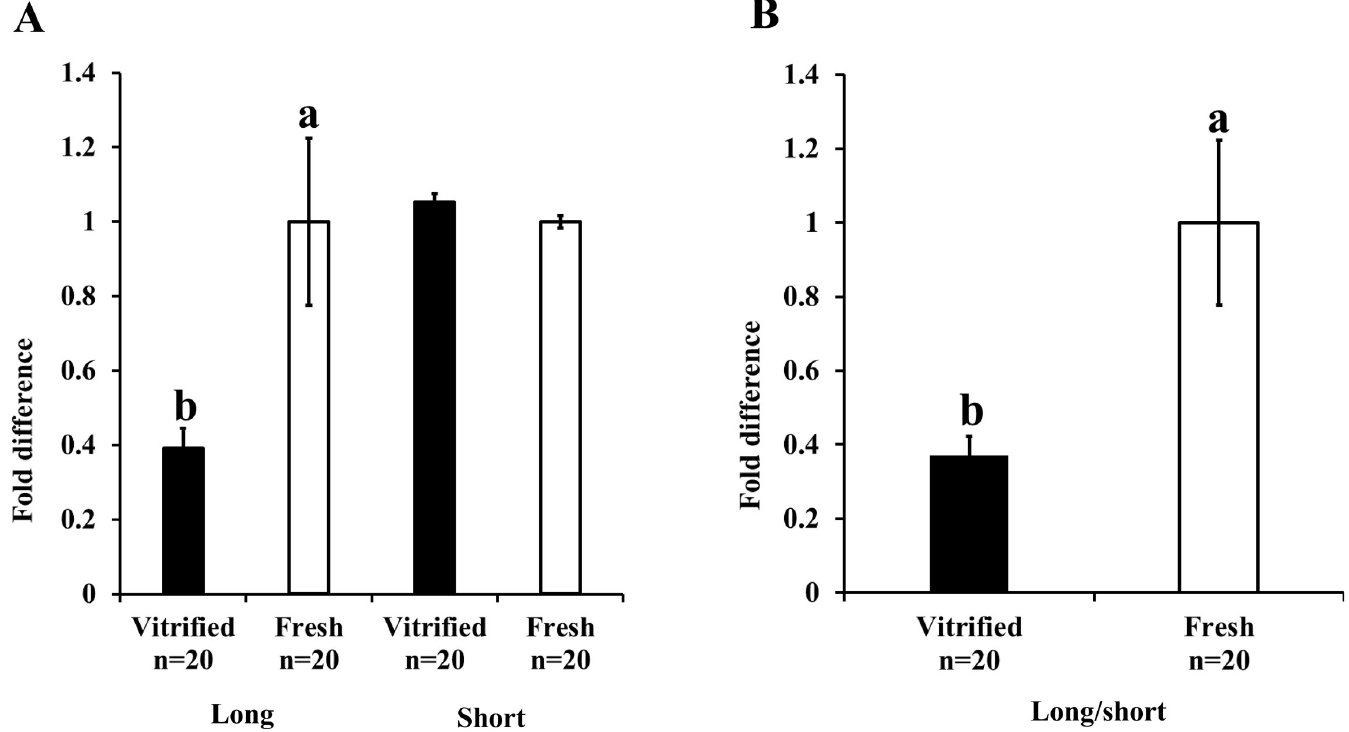
Fig 2. Effect of vitrification on the mitochondrial DNA integrity of embryos immediately after warming. The integrity of the mitochondrial genome was assessed according by the ratio of the Mt-number (long sequence/short sequence) predicted by real-time PCR targeting short and long mitochondrial sequences. A) Relative Mt- number predicted by PCR targeting the short and long mitochondrial sequences; the relative value for fresh embryos was taken as 1.0. B) Ratio of the Mt-numbers (Mt- number predicted by PCR targeting long sequence/Mt-number predicted by PCR targeting short sequence PCR). Value for fresh embryos was taken as 1.0. Bars with different letters represent differences between treatments (P < 0.05). Data are presented as mean ± SEM.